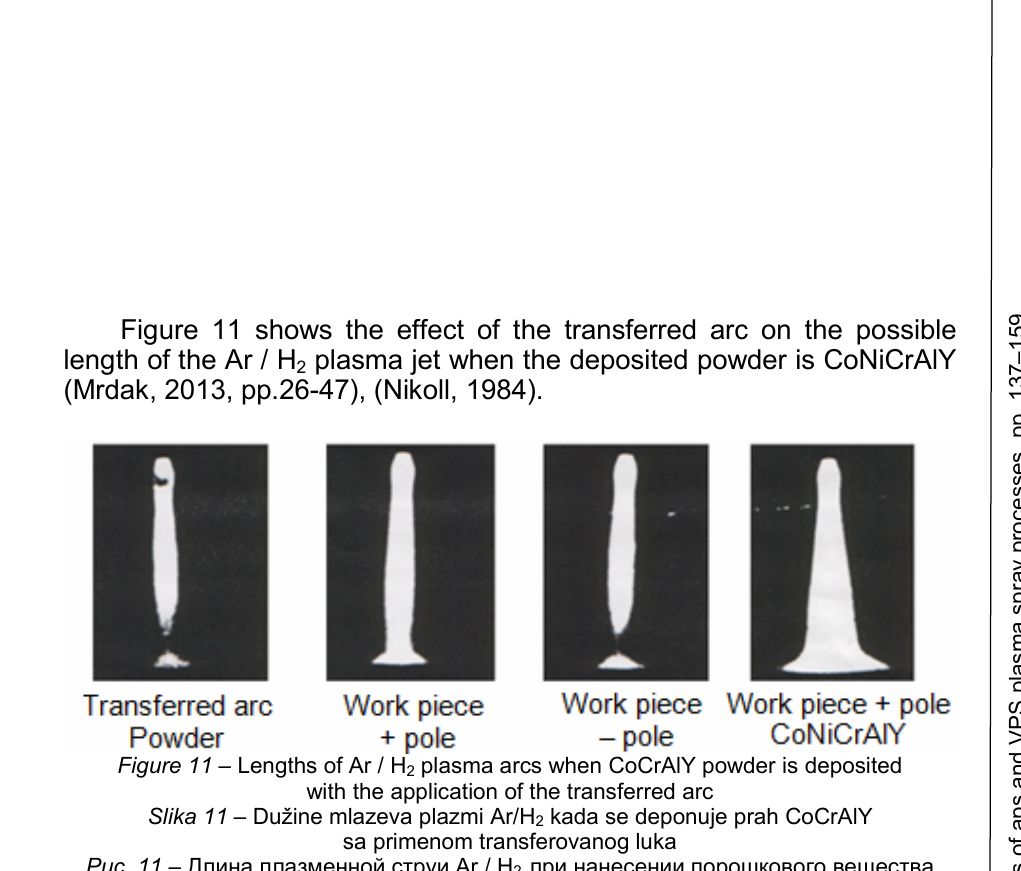
Figure 11 – Lengths of Ar / H 2 plasma arcs when CoCrAlY powder is deposited with the application of the transferred arc Рис . 11 – Длина плазменной струи Ar / H 2, при нанесении порошкового вещества CoCrAlY прямым